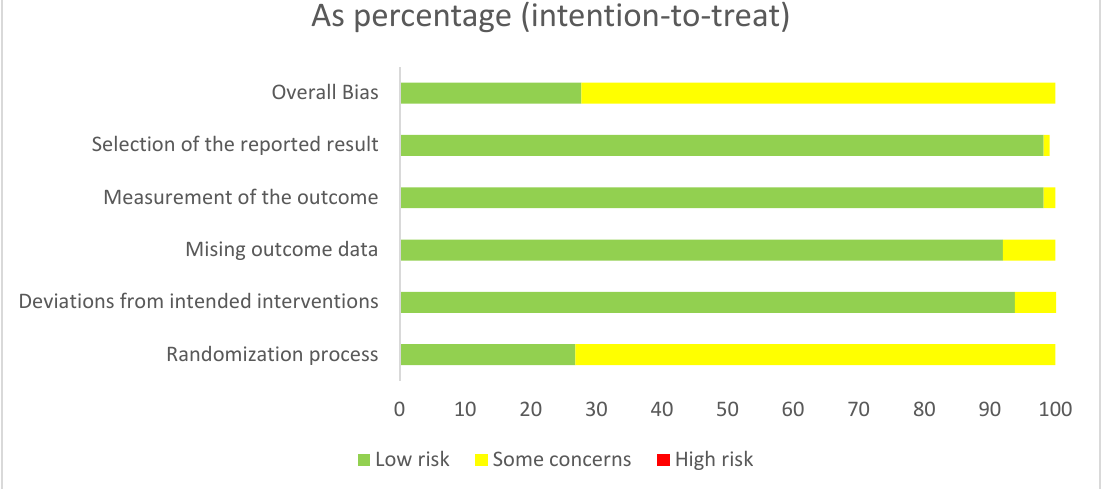
Figure 1. Risk of bias summary. Risk of bias was assessed according to the methods recommended by the Cochrane Collaboration[8] .